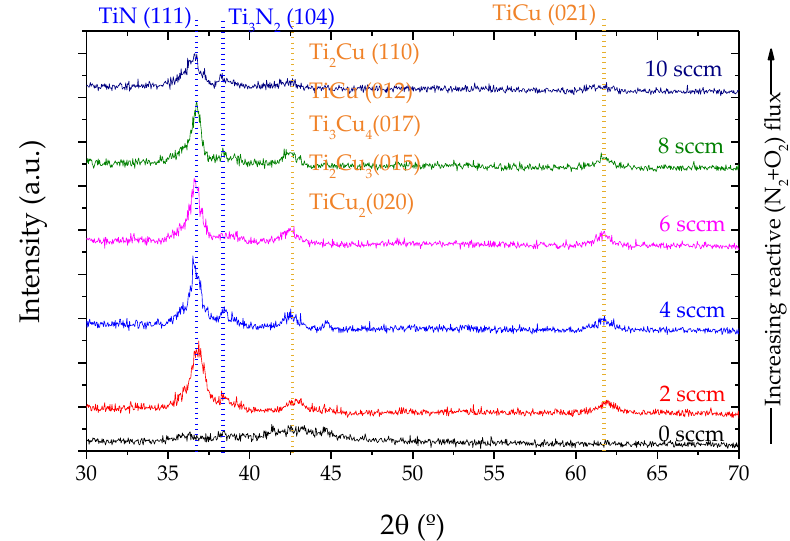
Figure 6. XRD di ff ractograms of the nanostructured TiCu(O,N) thin Figure 6. XRD diffractograms of the nanostructured TiCu(O,N) thin films.